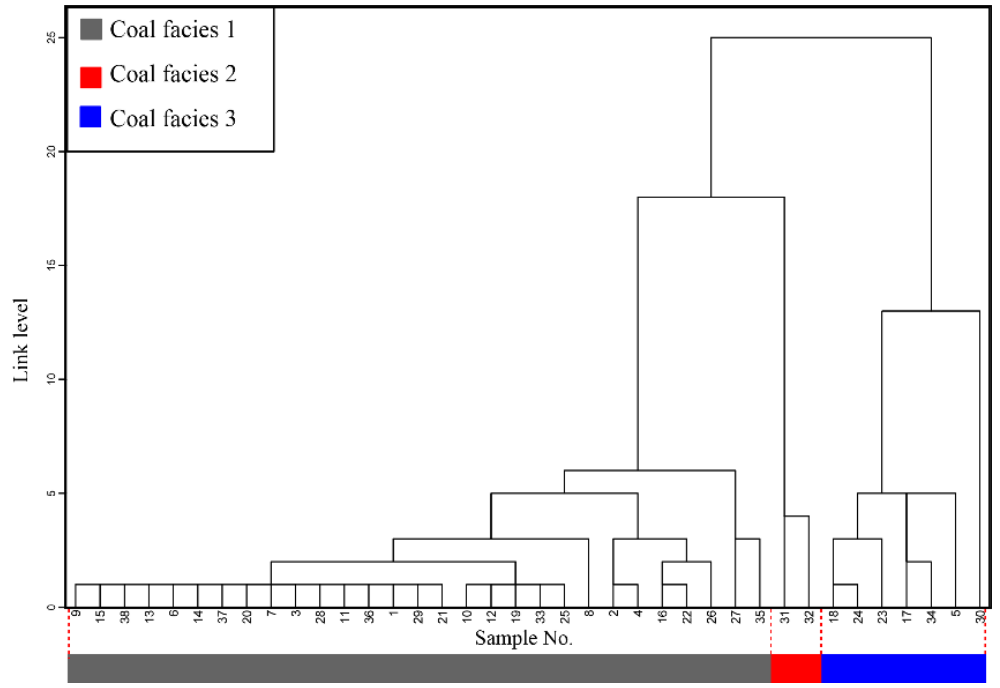
Figure 7. Dendrogram showing coal facies results of Q-cluster analysis.